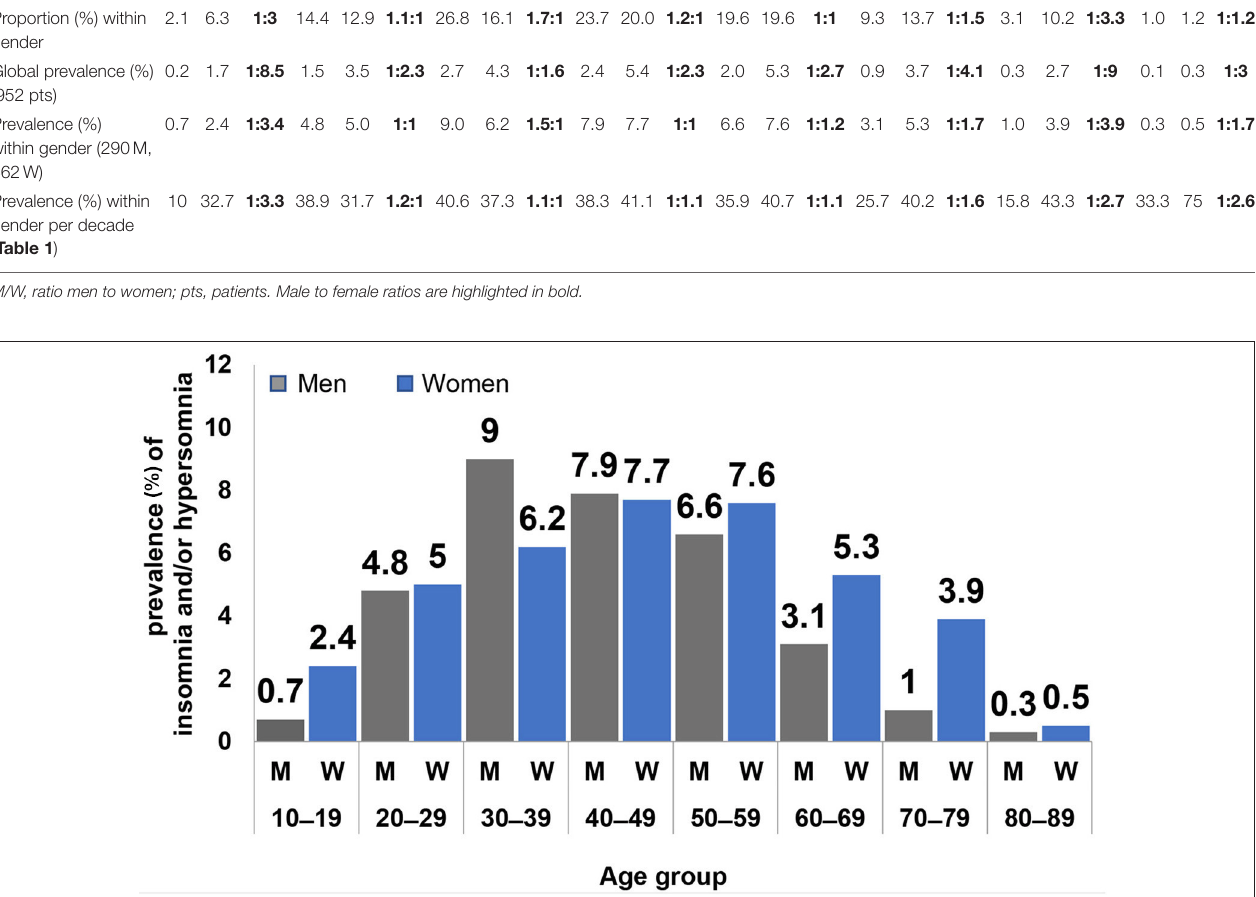
proportion of scores ≥ 8 was reported by female teenagers